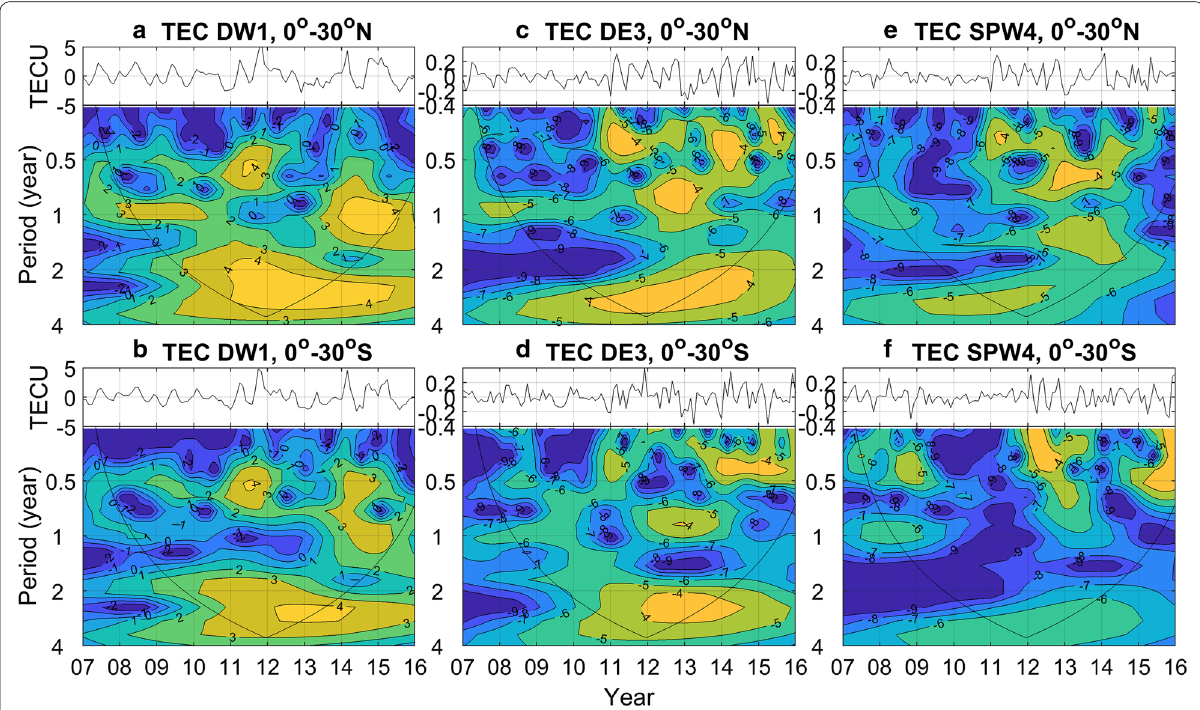
Fig. 2 Wavelet power spectra of a , b the TEC DW1, c , d DE3, and e , f SPW4 amplitude anomalies averaged within the latitude of a , c , e 0° to 30°N and b , d , f 0° to 30°S. Black curves indicate the cone of influence zone of the wavelet analysis. The panels above the spectra show the amplitude